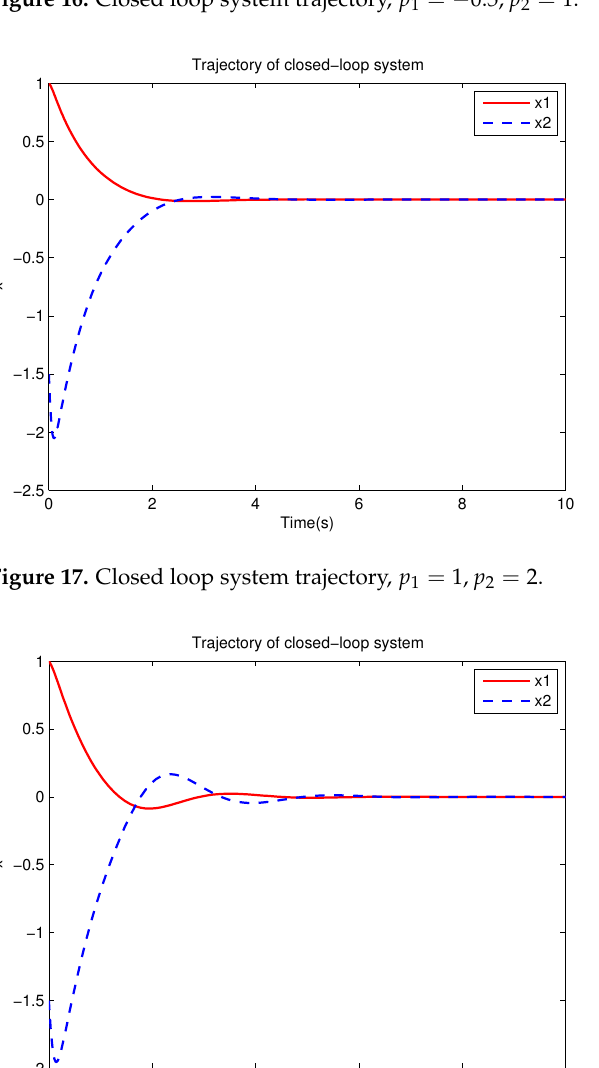
Figure 16. Closed loop system trajectory, p 1 = − 0.5, p 2 = 1.